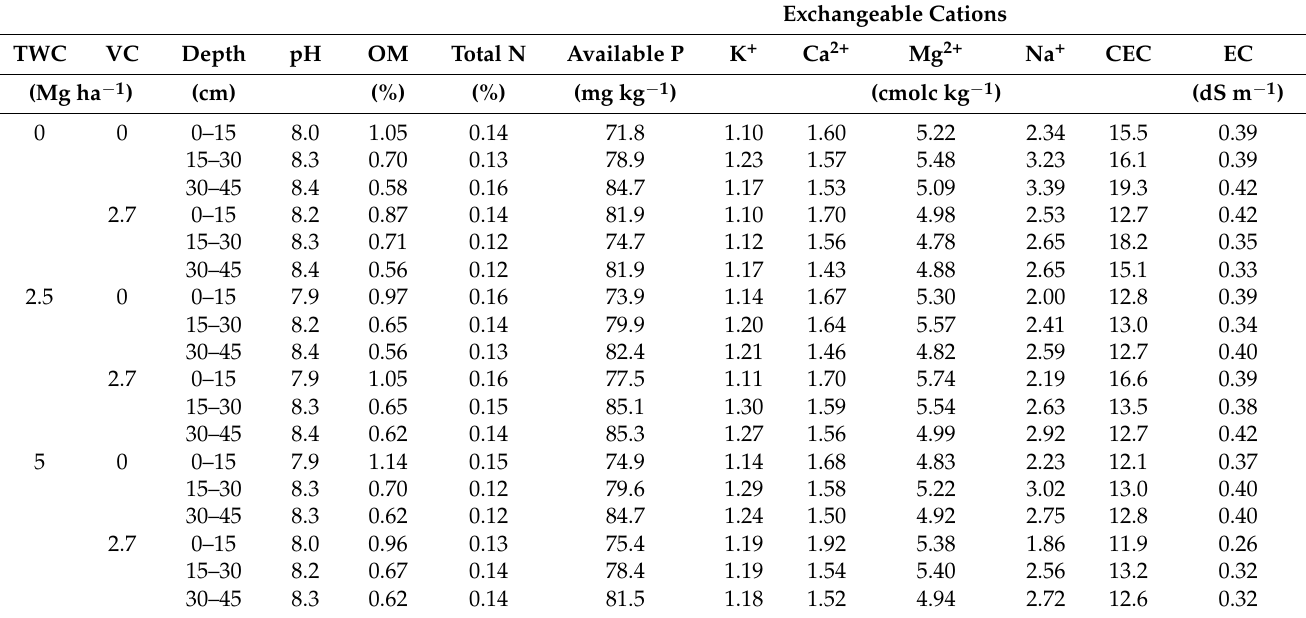
Table 2. Soil chemical properties in the study site after the torrefied wood chips (TWC) and vermi- compost (VC) treatment